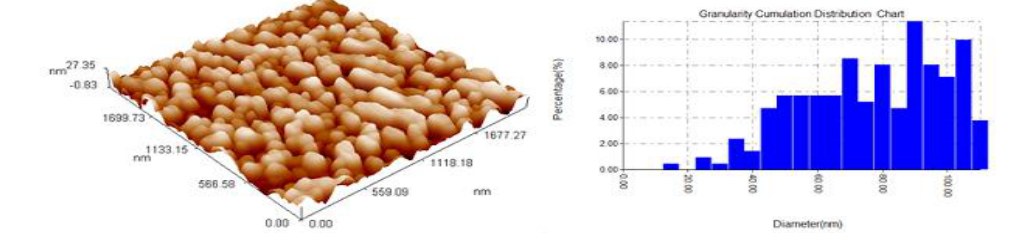
Fig.(c): AFM images for nanostructure at energy 400 mJ with (Avg. Diameter: 74.49 nm.